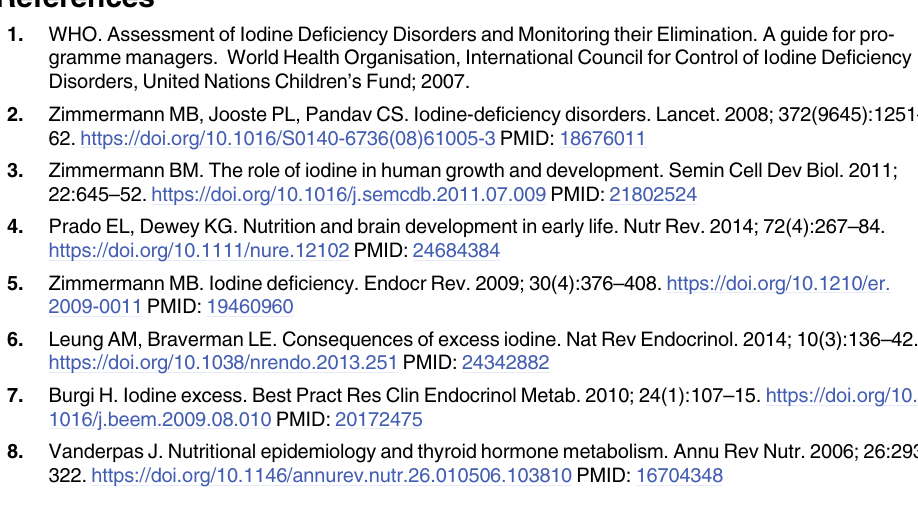
S2 Table. Associations between thyroid disturbances, TSH outside reference and elevated Tg with being in the two upper thirds of the ASQ-3 score ex. GM in different subgroups a . (cid:3) p < 0.05 # p = 0.051, p = 0.080 One missing from the variable Number of toys, n = 287 for adjusted effects.